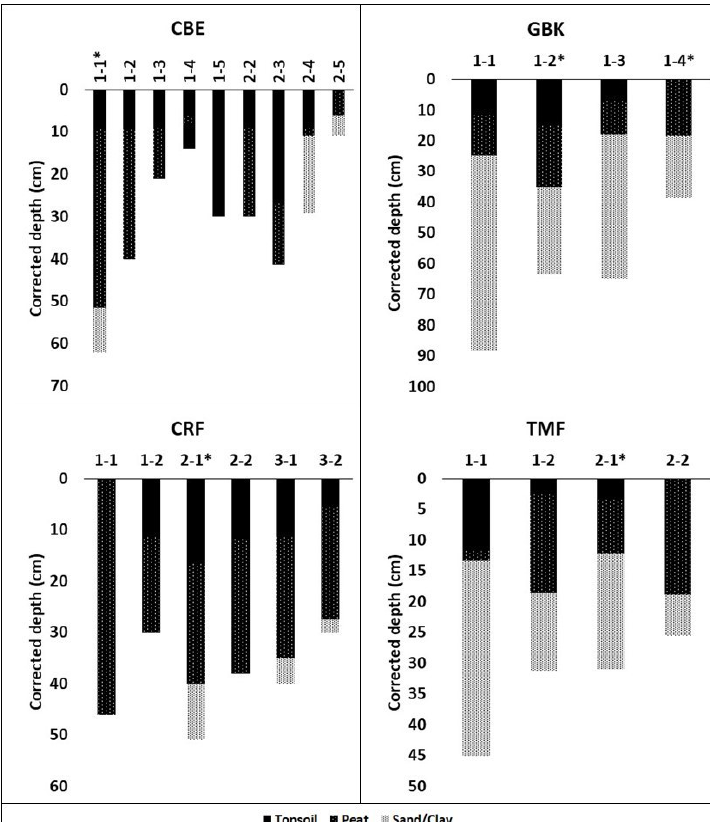
Figure A1. Core stratigraphies. Dated high marsh cores (asterisks) were CBE 1–1, CRF 2–1, GBK 1–2, and TMF 2–1; dated low marsh cores were CBE 1–5, CRF 3–2, GBK 1–4, and TMF 1–2. Corrected depth (cm) reflects correction for core compaction. Surface organic layer (“soil” in table ) overlying peat in several cores was black, fluffy, highly organic material overlying the brown peat layer below, which contained extensive plant roots that had not entirely decayed yet. The transition between these two layers was visually very distinct and also reflected by changes in dry bulk density.